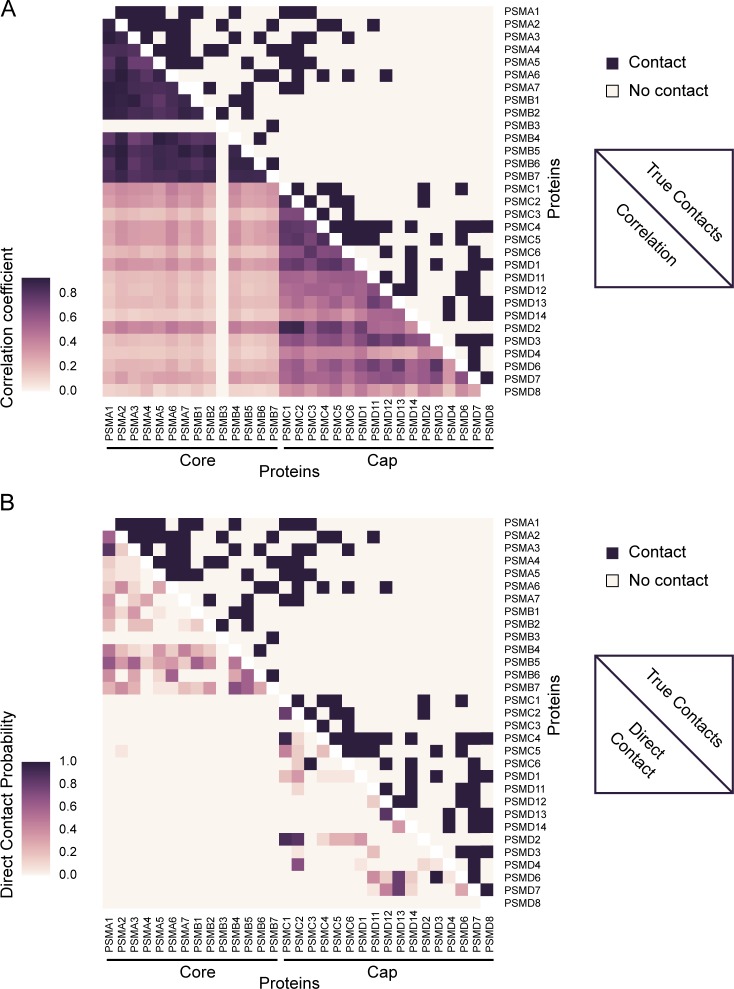
Prediction of direct contacts between subunits of the 26S proteasome.A. Matrix of true contacts (upper right, derived from PDB entry 4CR2 [47]) and correlation coefficients (lower left) for the 26S proteasome. Correlation identifies general sub-complex structure but fails to discriminate between direct and indirect interactions (6 out of top 10 predictions correct). B. Matrix of true contacts (upper right) and direct contact predictions (lower left) for the 26S proteasome. The direct contact method identifies many true contacts while strongly reducing the number of false positive predictions (9 out of top 10 predictions correct).